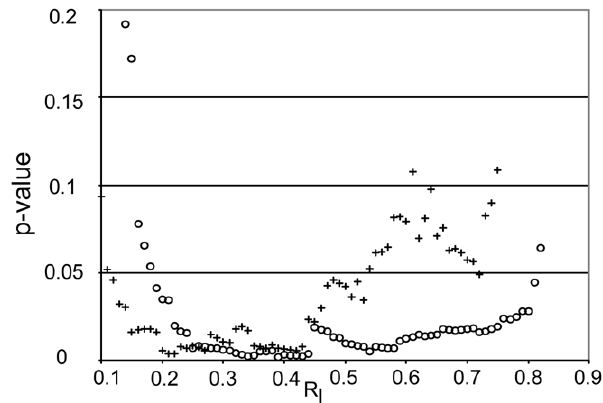
Figure 4. P-value for degradation end time vs. R I for total edge intensity (o) and directional edge intensity ( + ). Note the differences between total and directional edge intensity methods. While both methods show significance (p , 0.05) over a large range of R I , the total edge intensity is statistically different over almost the entire regime [.19, .81], while directional edge intensity is statistically different over the range from [.12, .53].